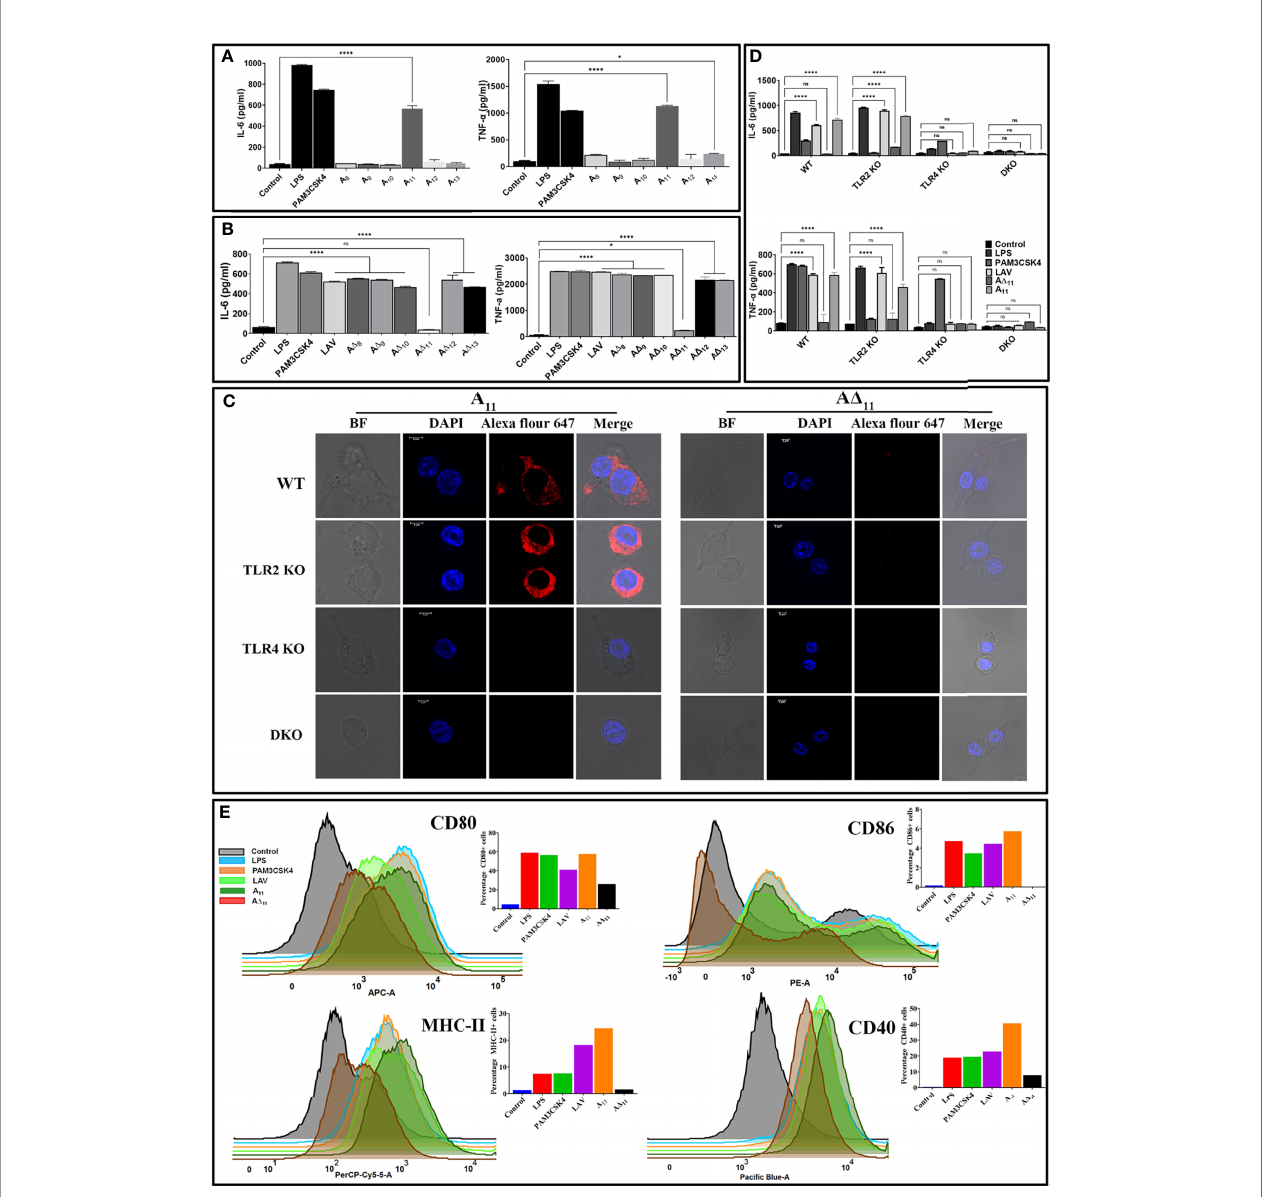
FIGURE 2 | 11 th domain of LigA (A 11 ) is involved in binding to TLR4 and subsequent signalling leading to activation and maturation of mouse macrophages. (A) Screening of pro-in fl ammatory response of individual domains of LAV in RAW264.7 cells. RAW264.7 cells were incubated with individual domains (A 8 -A 13 ) at concentration of 2 m g/ml pre-treated with PMB for 24h at 37°C in presence of 5%CO 2 and supernatant was collected to measure levels of IL-6 and TNF- a by ELISA. (B) Screening of pro-in fl ammatory response of domain deletion mutants of LAV in RAW264.7 cells. RAW264.7 cells were stimulated with LAV or corresponding deletion mutants (A Δ 8 -A Δ 13 ) at a concentration of 2 m g/ml pre-treated with PMB for 24h at 37°C in the presence of 5%CO 2 and supernatant was collected to measure levels of IL-6 and TNF- a by ELISA. (C) Binding of A 11 with the mouse TLR4. WT, TLR2KO, TLR4KO or DKO macrophages cell lines were incubated with A 11 and A Δ 11 (2 m g/ml) for 30min. After washing, cells were fi xed and stained with respective antibodies and analysed by confocal microscope as described in materials and methods. (D) The pro-in fl ammatory response of mouse macrophages stimulated with A 11 . WT, TLR2KO, TLR4KO and DKO bone marrow-derived macrophages cell lines were treated with LAV, A 11, A Δ 11 (2 m g/ml), LPS (500ng/ml) or PAM3CSK4(20ng/ml) for 24h at 37°C in presence of 5%CO 2 and levels of IL-6 and TNF- a in the supernatants were measured with ELISA. (E) A 11 enhanced the expression of surface markers in mouse macrophages. RAW 264.7 cells were incubated with LPS (500 ng/ml) or PAM3CSK (20ng/ml) or LAV or A 11 or A Δ 11 (2 m g/ml) for 24h at 37°C in presence of 5%CO 2 . Cells were stained with fl uorochrome-conjugated antibodies and then analyzed by Flow cytometry as described in materials and methods. Control indicates uninduced or unstimulated cells, E . coli LPS (500ng/ml) or PAM3CSK4 (20ng/ml) as TLR4 and TLR2 ligands respectively were used as positive controls in all experiments wherever indicated. Data are representative of three different experiments. Signi fi cant differences were calculated using the one or two way ANOVA (****, *, ns indicates P < 0.0001, P < 0.05 and non-signi fi cant